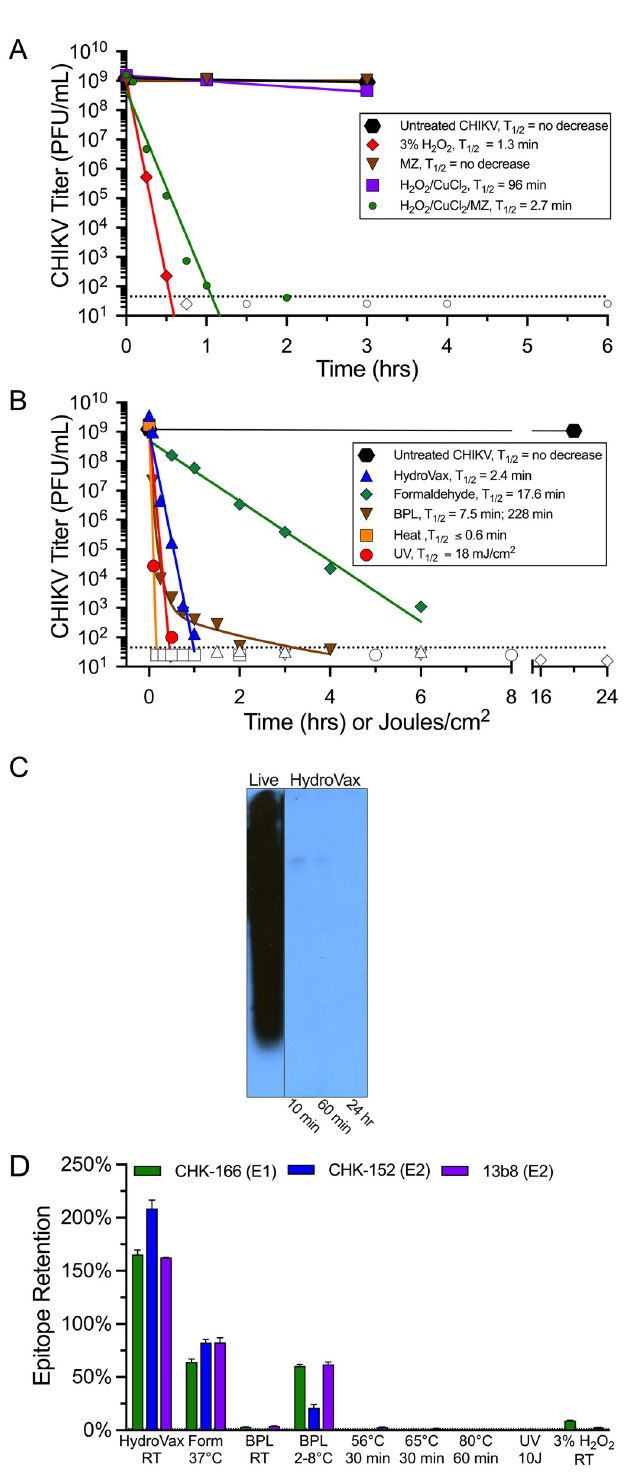
Fig 2. Virus inactivation kinetics and impact on CHIKV genomic RNA and neutralizing epitopes. (A) Virus inactivation kinetics based on exposure to 3% H 2 O 2 were compared to a site-directed dual oxidation approach (H 2 O 2 / CuCl 2 /MZ) and selected subcomponents of the site-directed dual oxidation system at matched concentrations (H 2 O 2 / CuCl 2 or MZ). (B) Kinetics of virus inactivation based on an optimized HydroVax vaccine approach were compared to other common virus inactivation methods including 0.01% formaldehyde, 0.10% BPL, heat inactivation at 80˚C, and UV irradiation. Inactivation studies were performed at room temperature except for formaldehyde, which was